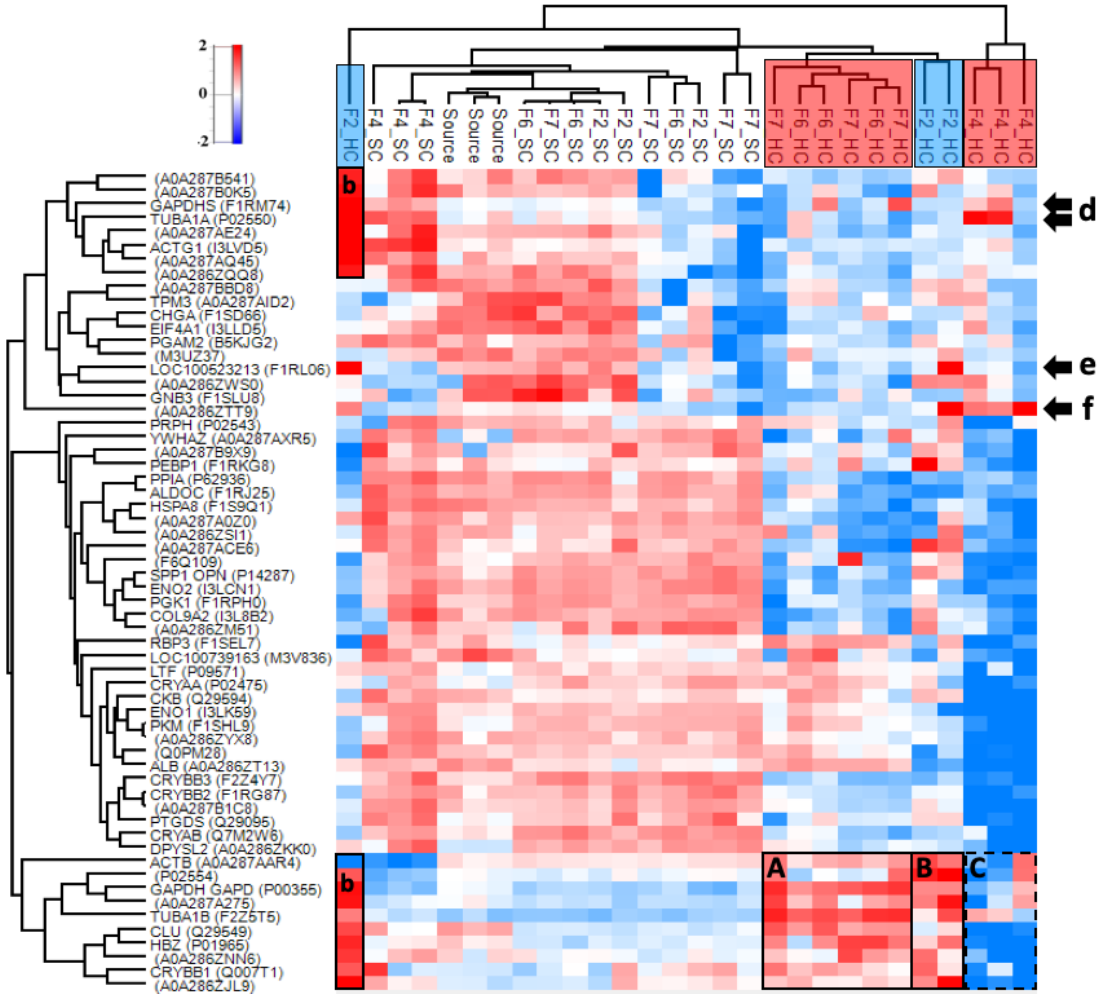
Figure 6. Heatmap of the top 60 most abundant proteins in porcine vitreous humor in at least three samples after median normalization (728 proteins). Distinct clusters are observed for the HC, SC, and plasma source. The HC subsections of the tested formulations do not cluster based on their anionic or neutral surface charge. The boxes ( A – B ) indicate the enrichment of tubulins, glyceraldehyde phosphate dehydrogenase (GAPDH), hemoglobin (HBZ), Dickkopf-related protein 3 (A0A286ZNN6), and clusterin (CLU) on the 50 nm anionic and 100 nm PEG-coated liposomes, which were depleted or less enriched on the HA-coated liposome (dashed box ( C )). Interestingly, variants of glyceraldehyde phosphate dehydrogenase (GAPDHS) and tubulin (TUBA1A) were enriched on the HA-coated liposomes ( d ). One replicate of the PEG-coated 100-nm liposome showed high enrichment of these variants along with immunoglobulin family proteins (boxes ( b , e )), which also enriched on the HA-coated liposome ( d , f ). An obsolete immunoglobulin subtype was enriched on the HA-coated liposome ( e ). The range for relative enrichment ( red ) and depletion ( blue ) is two standard deviations from the mean on the log 2